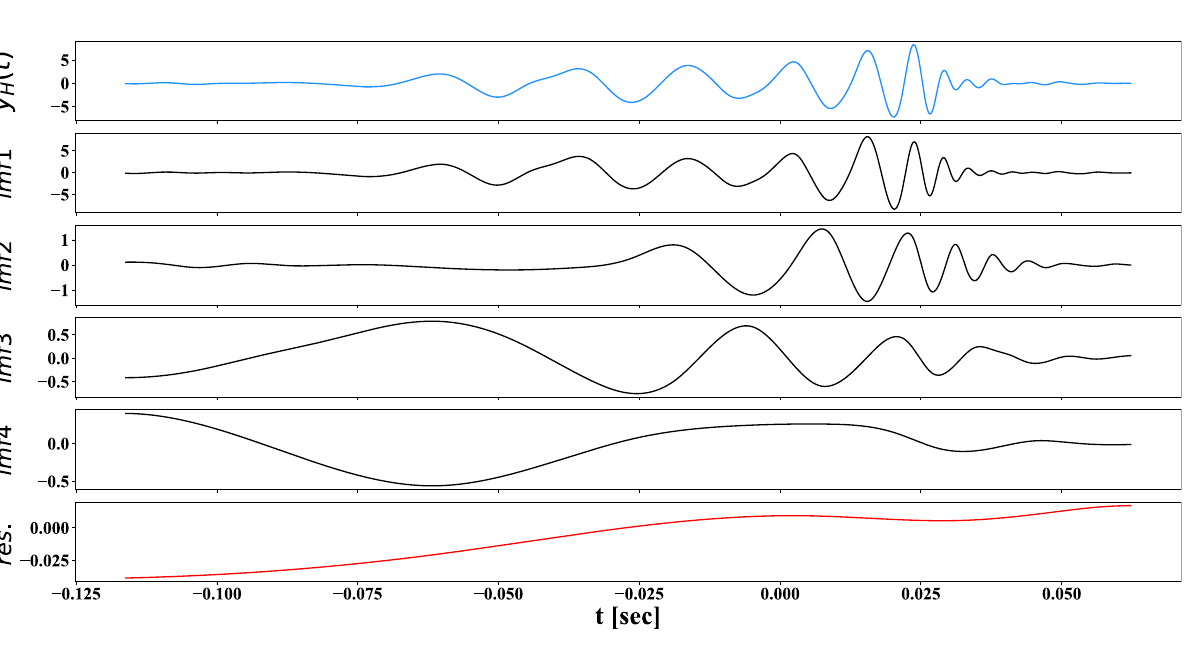
Figure 9. Intrinsic mode functions of extracted waveform of event GW150914 in H. The intrinsic mode functions (IMF1 to IMF4) and residual (res.), for the extracted waveform ˜ y ( t ) of the event GW150914 in H from empirical mode